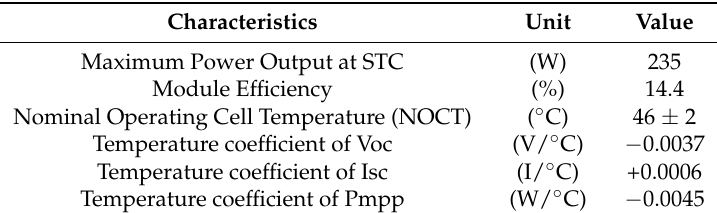
Figure 1. PV panel configurations schematic. Table 1. PV module electrical